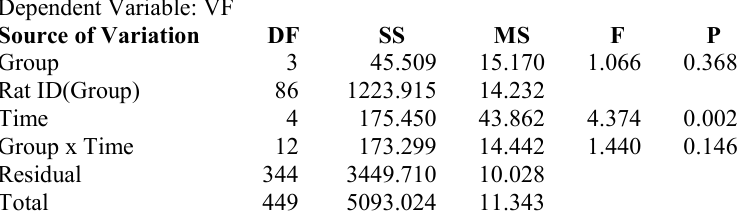
Figure A4. Contralateral Two-Way RM ANOVA statistical analysis for behavioral portion (presented in Figure 2).